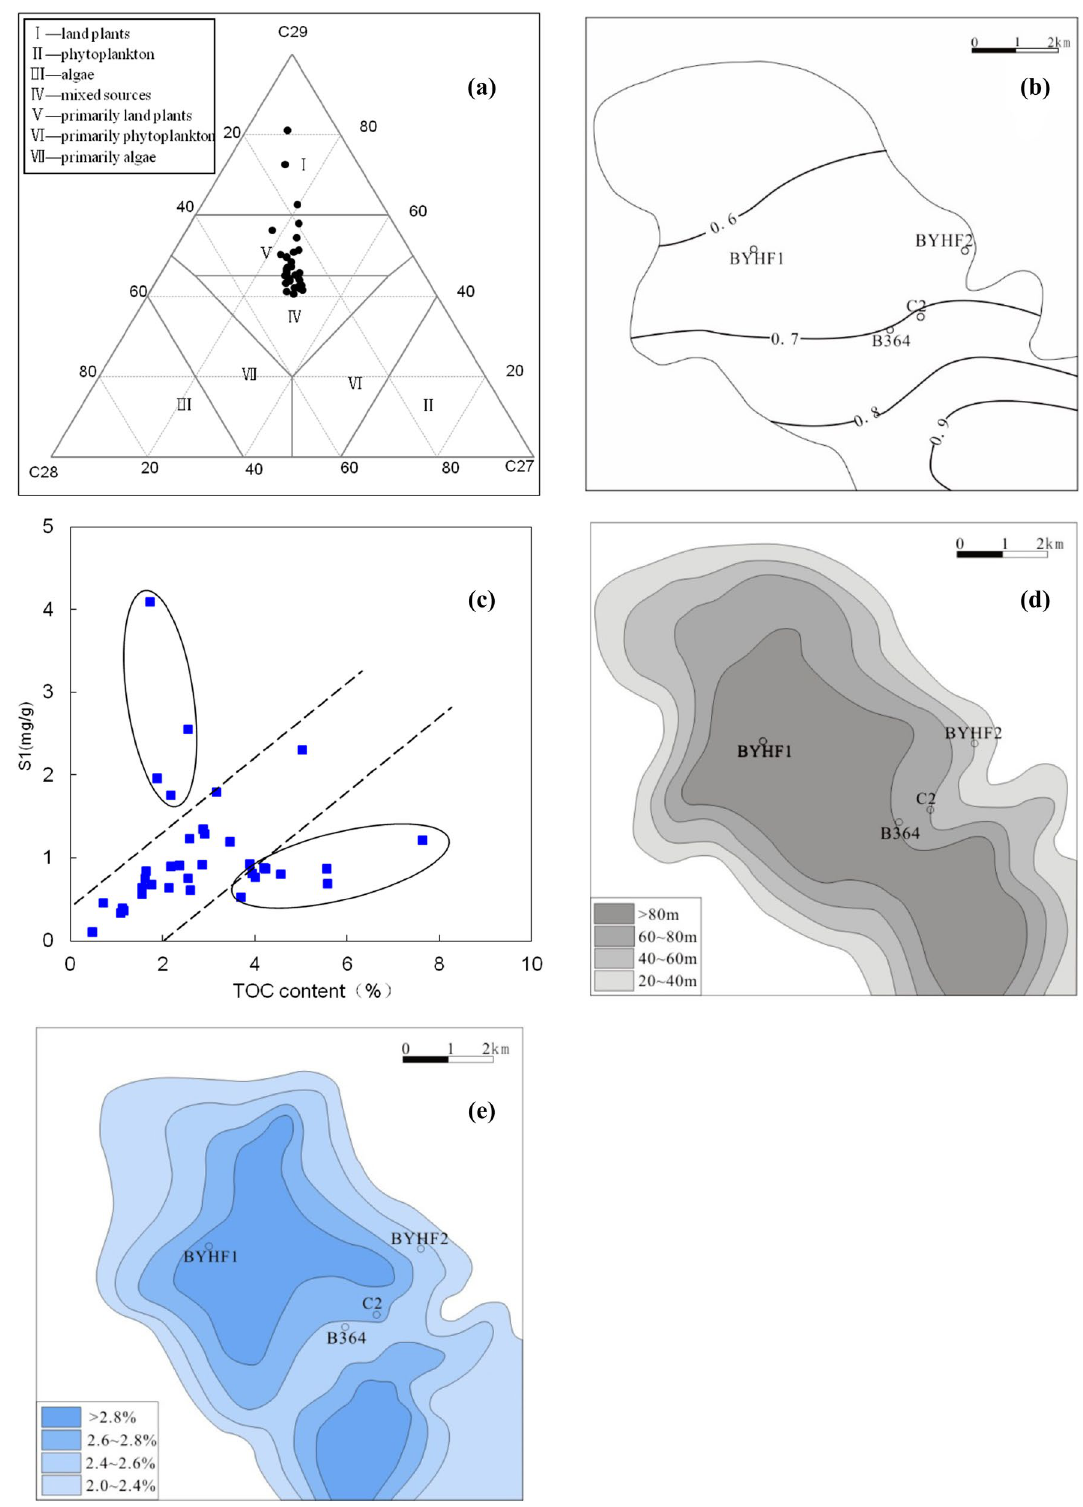
Fig. 5 a The triangular plot of biomarker parameters of core samples; b R positively with TOC contents; d thickness isoline of ORI 5; e TOC content isoline of ORI